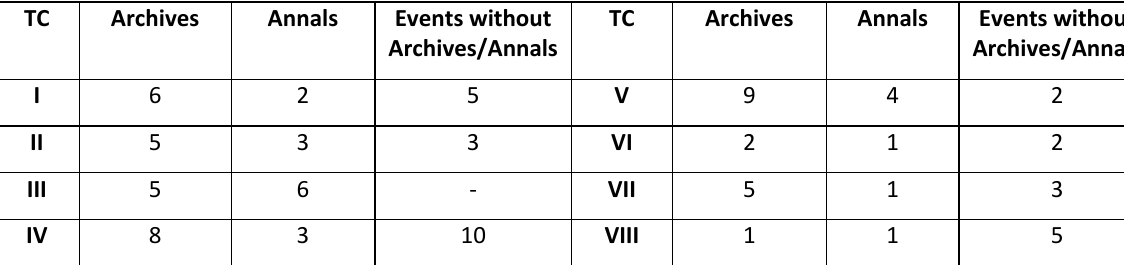
Table 2: Number of Archives and Annals volumes published during 2012 - 2016 (incl. Symposium and GSW proceedings) and events without Archives/Annals